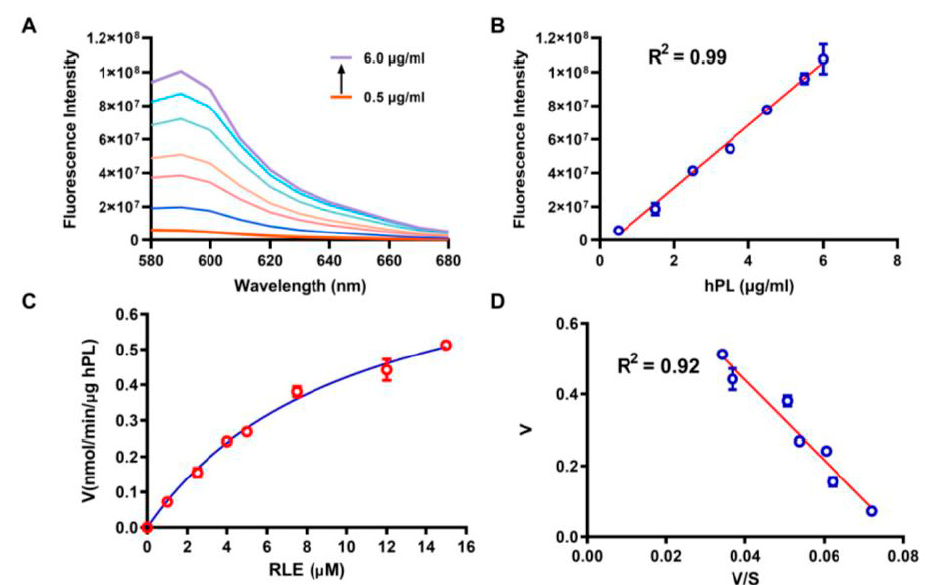
Figure 3. ( A ) Fluorescence spectra of RLE (5 µM) incubated with increasing concentrations of hPL (0.5–6 µg/mL) in Tris-HCl. ( B ) The linear relationship between fluorescence intensity and hPL concentrations (0.5–6 µg/mL) in Tris-HCl. ( C ) Hydrolytic kinetics of RLE (5 µM) in hPL at 37 °C. ( D ) Eadie–Hofstee plot. All data are expressed as mean ± SD.